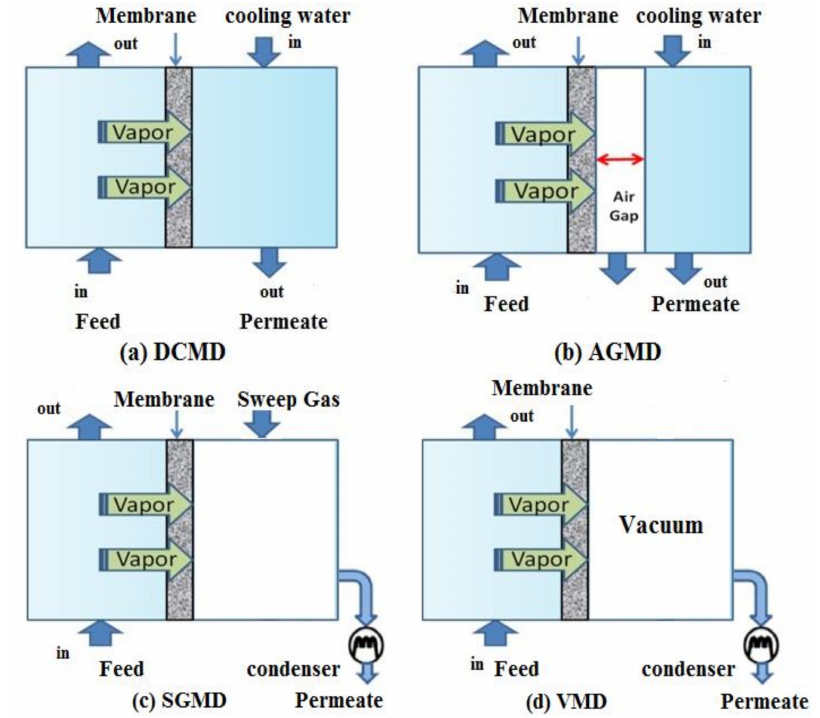
Figure 1. Schematic illustrations of the membrane distillation (MD) configurations